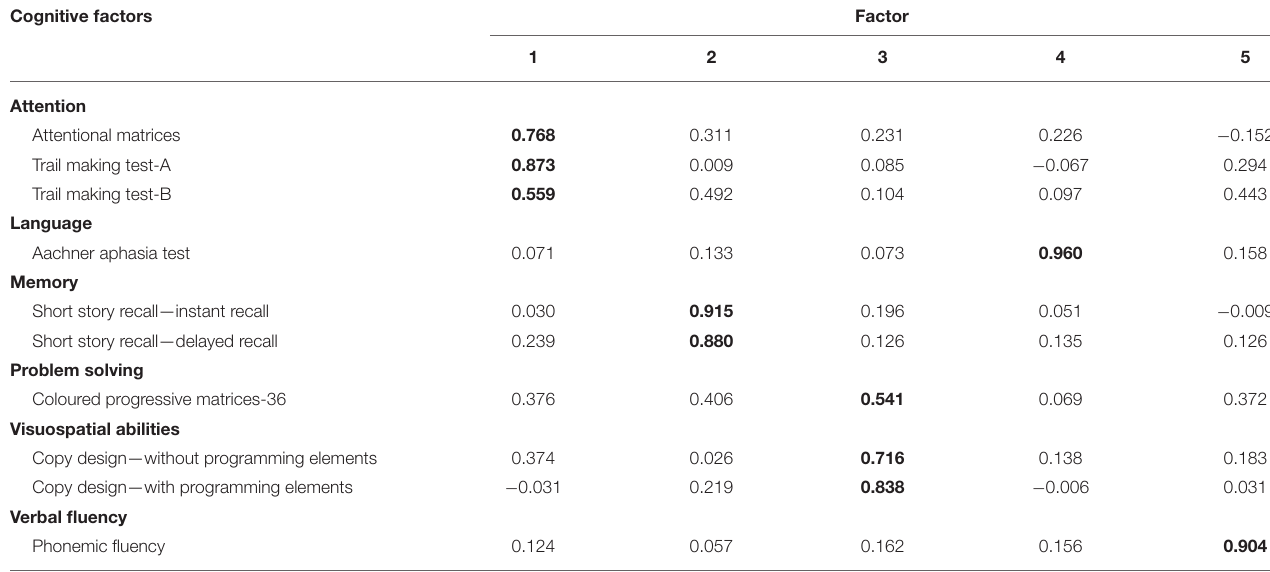
TABLE 2 | Pattern matrix for the principal components analysis—cognitive factors (T0). Cognitive factors